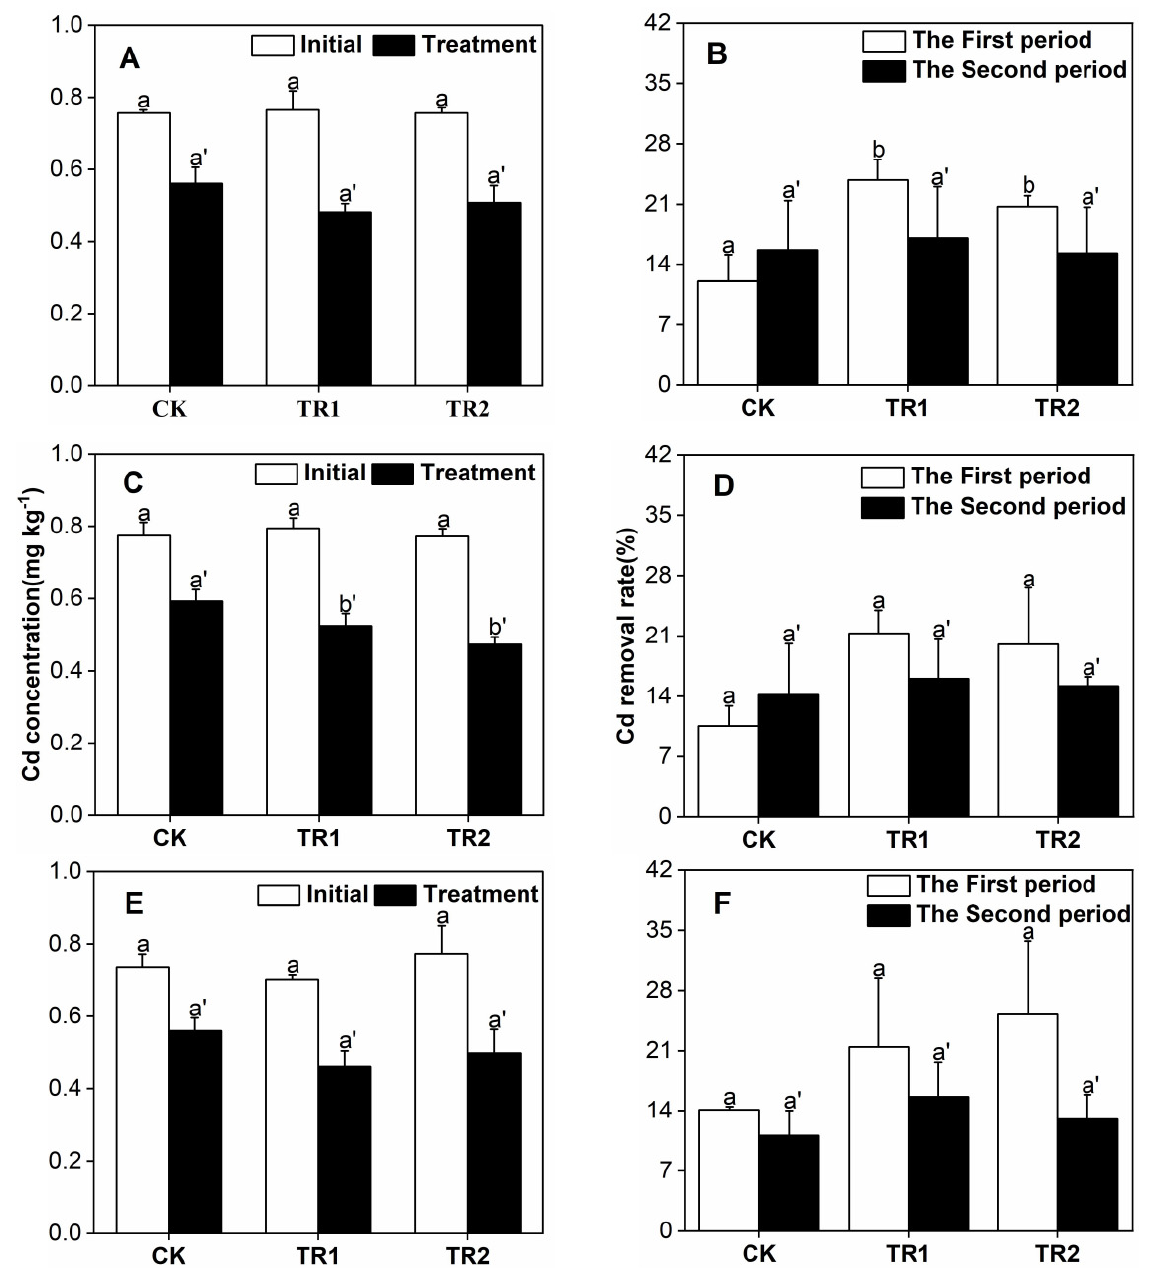
Figure 7. Soil Cd Concentration and Removal Rate. ( A ) First period intercropping papaya, ( B ) Second period intercropping papaya, ( C ) First period intercropping grapefruit, ( D ) Second period in ‐ tercropping grapefruit, ( E ) First period intercropping fig, ( F ) Second period intercropping fig. The different letters above the column indicate the significant differences among different treatments at p < 0.05.